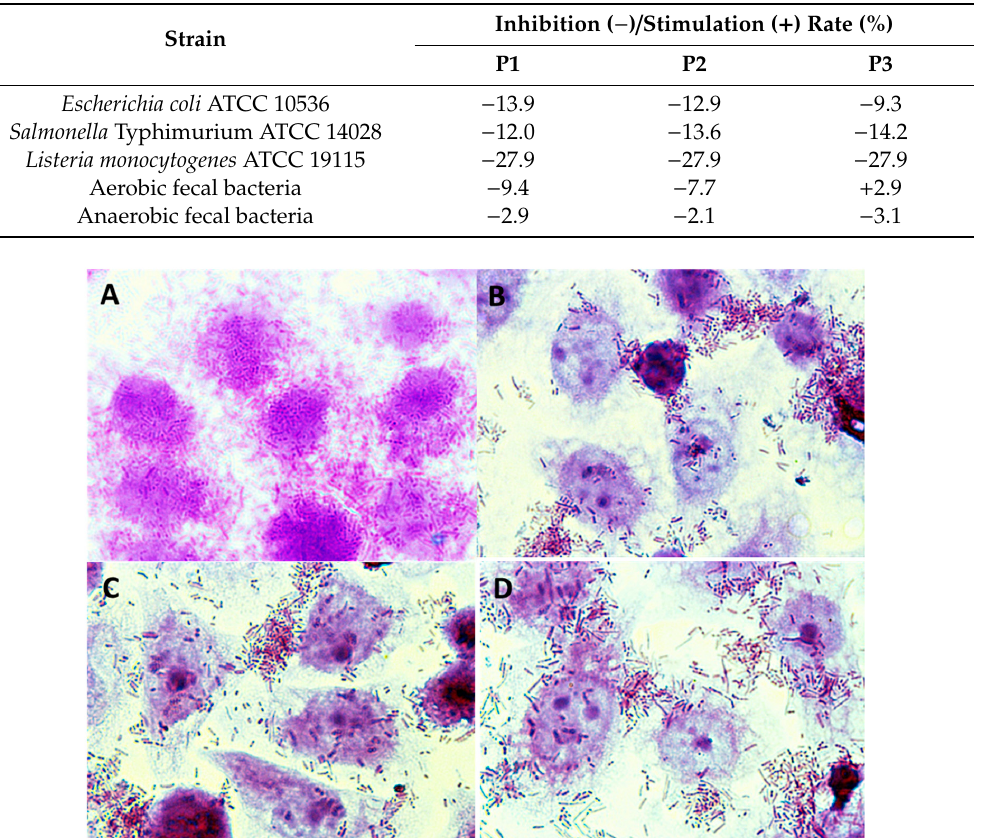
Figure 9. Microphotographs (magnification × 1000) showing adherence of E. coli ATCC 10536 to Caco-2 cells in the presence and without apple pomace hydrolysates: ( A ) E. coli ATCC 10536, ( B ) E. coli ATCC 10536 + P1 preparation, ( C ) E. coli ATCC 10536 + P2 preparation, ( D ) E. coli ATCC 10536 + P3 preparation. Stained with 0.5% crystal violet.